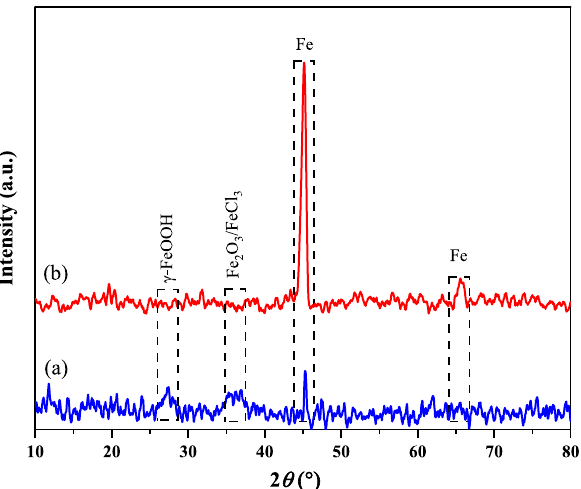
Figure 12. GIXRD patterns of the MS surface immersed in 1 M HCl ( a ) and 1 M HCl solution containing 800 ppm FV extract ( b ) after 6 h of immersion.